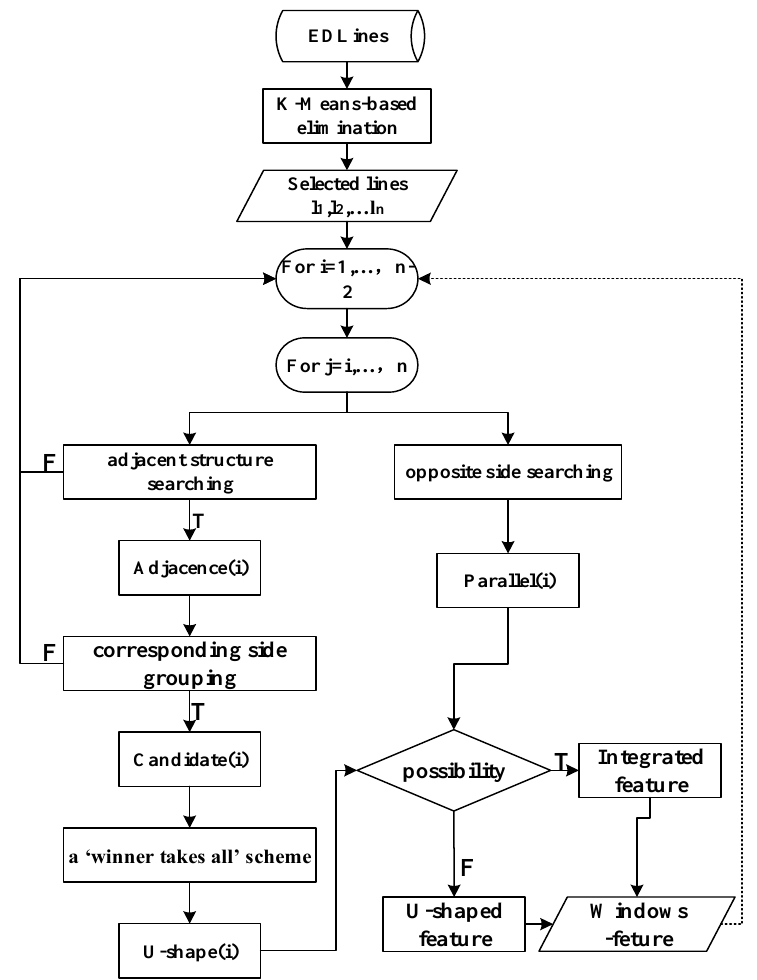
Figure 5. Flowchart of the window feature grouping